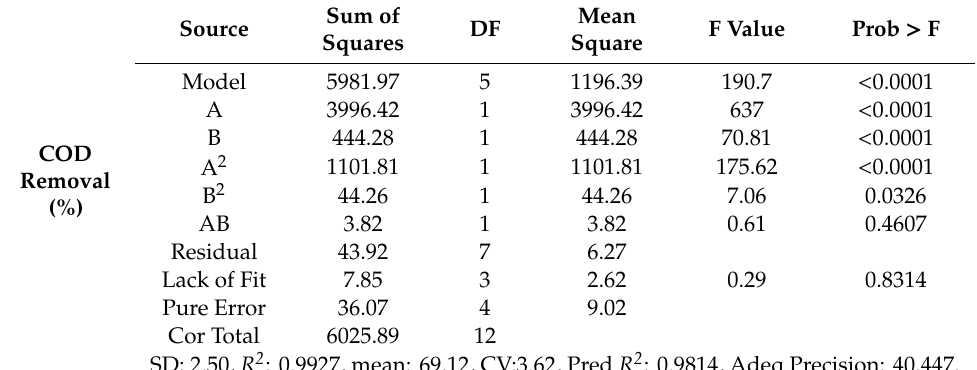
Table 4. ANOVA for COD, TSS, color, and NH 3 -N removal. A: POME dosage, B: aeration time.